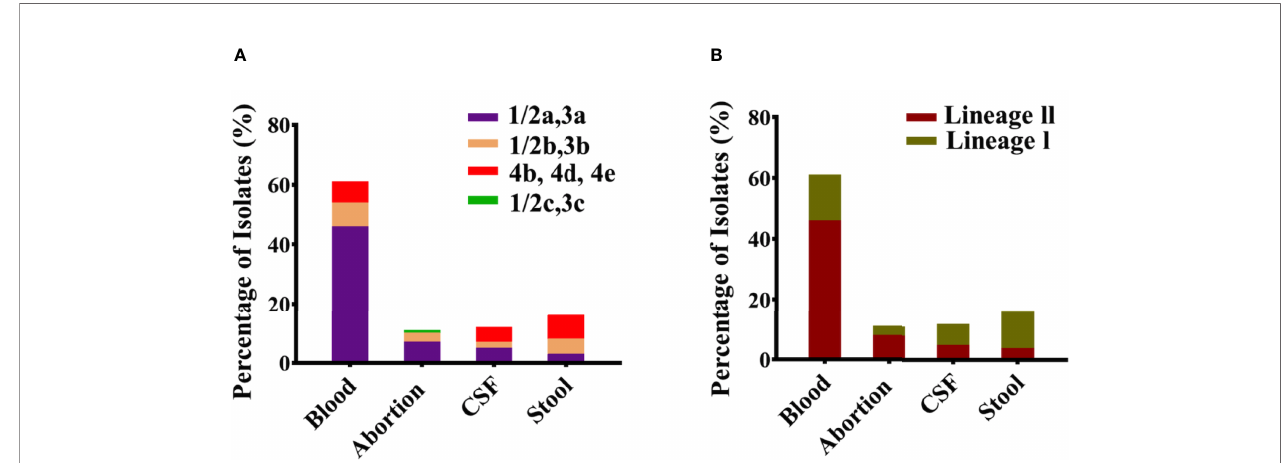
FIGURE 1 | Classi fi cation of serotypes and lineages for all clinical Listeria monocytogenes isolates. (A) Serotypes 1/2a, 1/2b, 1/2c, and 4b representing individually each group/category of blood, abortion, cerebrospinal fl uid (CSF), and stool isolates (n = 60). (B) Lineage I and Lineage II representing individually each group/ category of blood, abortion, CSF, and stool isolates (n =